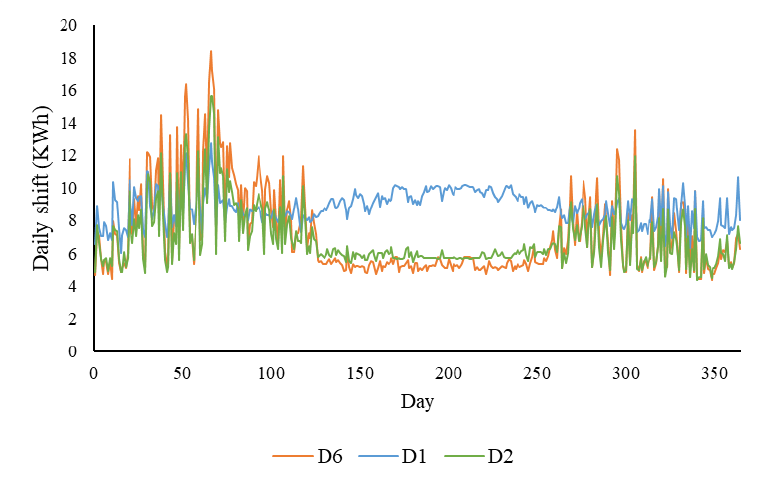
Figure 8. A comparison of the daily shifts for D 2 , D 6 , and D 1 under the measured power rate